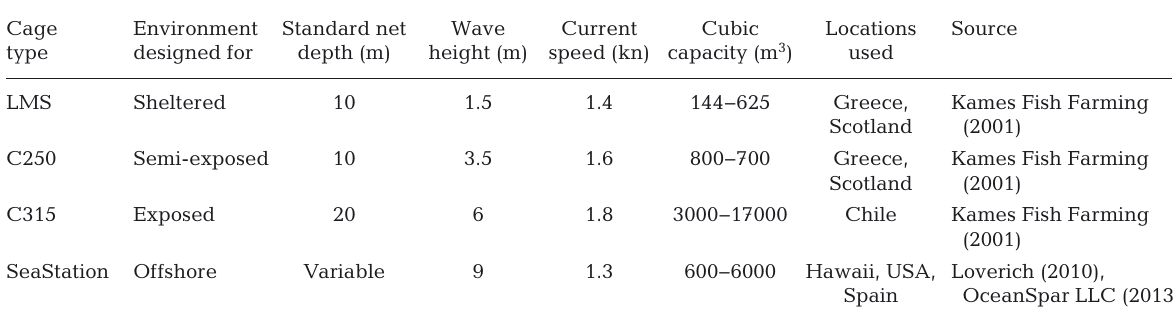
Table 1. Maximum threshold values for the 4 cage